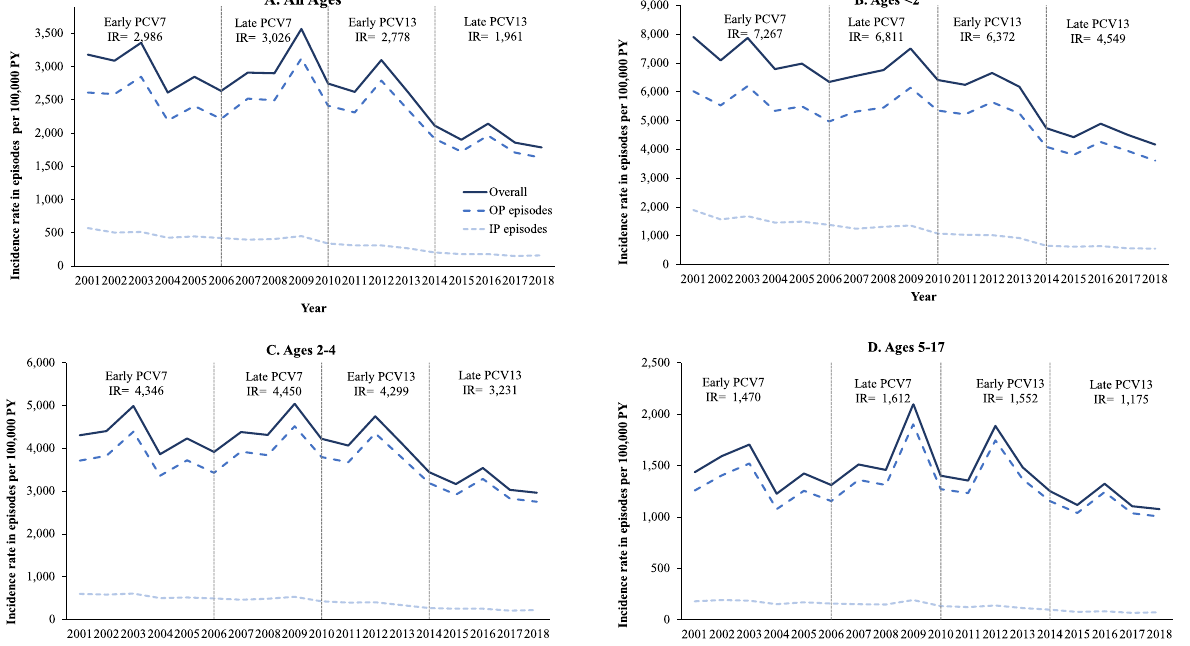
Fig. 2 Trends in annual IRs of ACP episodes per 100,000 PY among Medicaid‑insured children aged < 18 years (2001–2018). Notes: Average IRs for total ACP episodes are shown for each PCV period. All patients’ month and day of birth was imputed as July 1st. Age at onset was calculated as the difference between condition start date and imputed birth date. Patients with negative age at onset were included in the age 0–1 year cohort. Abbreviations: IP, inpatient; IR, incidence rate; OP, outpatient; PCV, pneumococcal conjugate vaccine; PY,